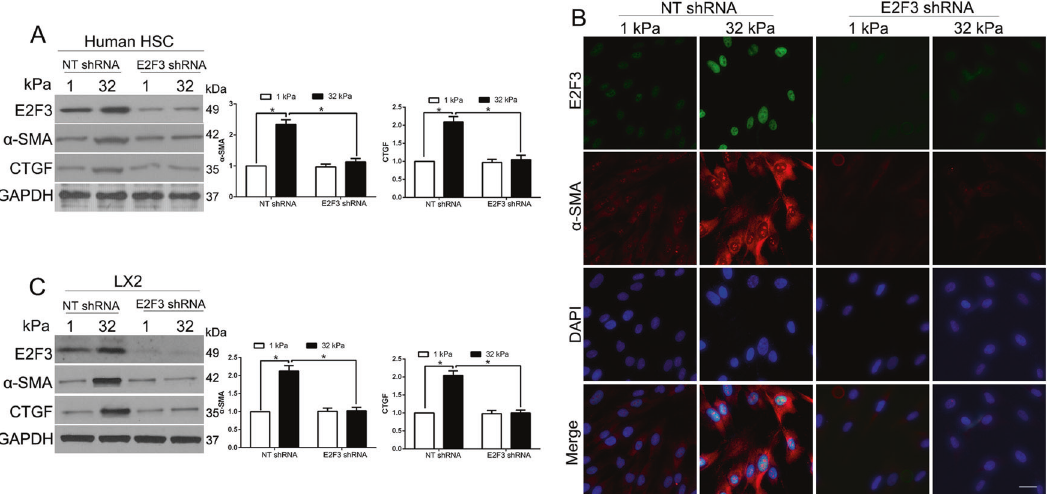
Fig. 2 Stiffness induces HSC activation by an E2F3-dependent mechanism. A Primary human HSCs on 1 or 32 kPa were transduced with lentiviruses encoding NT shRNA or E2F3 shRNA. Stiffness-mediated HSC activation was abrogated by E2F3 knockdown. * P < 0.05 by ANOVA, n = 3. B Primary HSCs seeded on a 1 or 32 kPa gel were transduced with NT shRNA or E2F3 shRNA for IF. Stiffness-mediated upregulation of α -SMA and E2F3 was abrogated by E2F3 gene deletion. Cell nuclei were counterstained by DAPI. C WB revealed that stiffness-mediated HSC activation was abrogated by E2F3 gene deletion. * P < 0.05 by ANOVA, n = 3